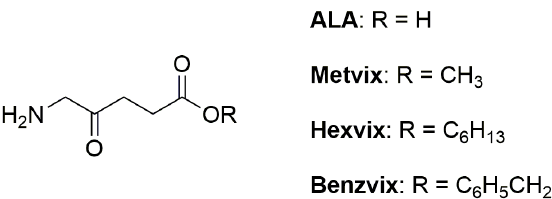
Figure 7 - Structures of ALA, Metvix, Hexvix and